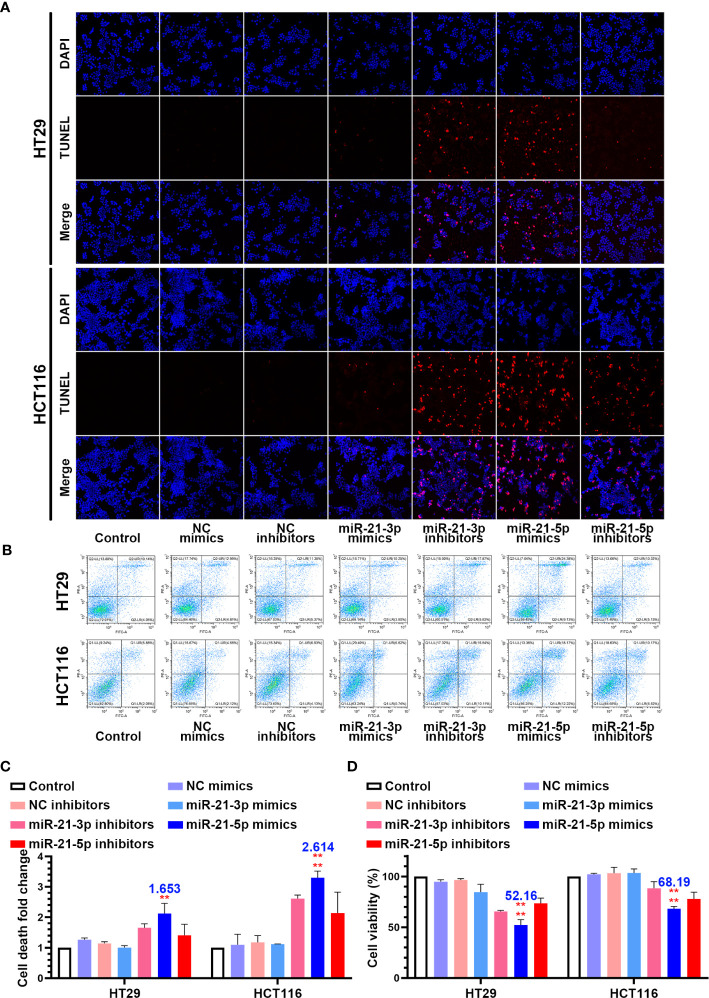
Overexpression of miR-21-5p induced cell death and repress cell viability in colorectal cancer (CRC) cells lines. (A) HT29 and HCT116 cells were transferred by miR-21-3p/miR-21-5p mimics and inhibitors, and cell death was determined by TUNEL stain assay. (B, C) Annexin V and PI staining flow cytometric analysis of cell death in miR-21-3p/miR-21-5p mimic and inhibitor transfected HT29 and HCT116 cells. (D) CCK-8 assay of HT29 and HCT116 cell viability changes with miR-21-3p/miR-21-5p mimics and inhibitors transfection. The bars and error bars indicate the mean ± SD. **p < 0.01, ****p < 0.001.